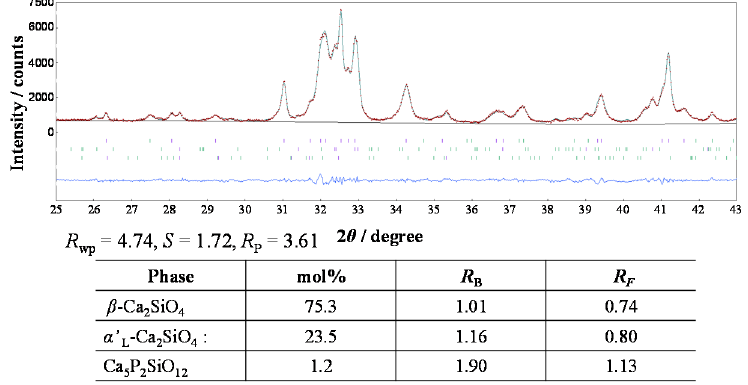
Figure 6. Observed profile intensities (red symbol: t), fitted patterns (green solid lines), and difference curves (blue solid lines in lower part of diagrams) obtained from the (Ca 1.95 Eu 2+0.02 □ 0.03 )(Si 0.94 P 0.06 )O 4 annealed at 1473 K.